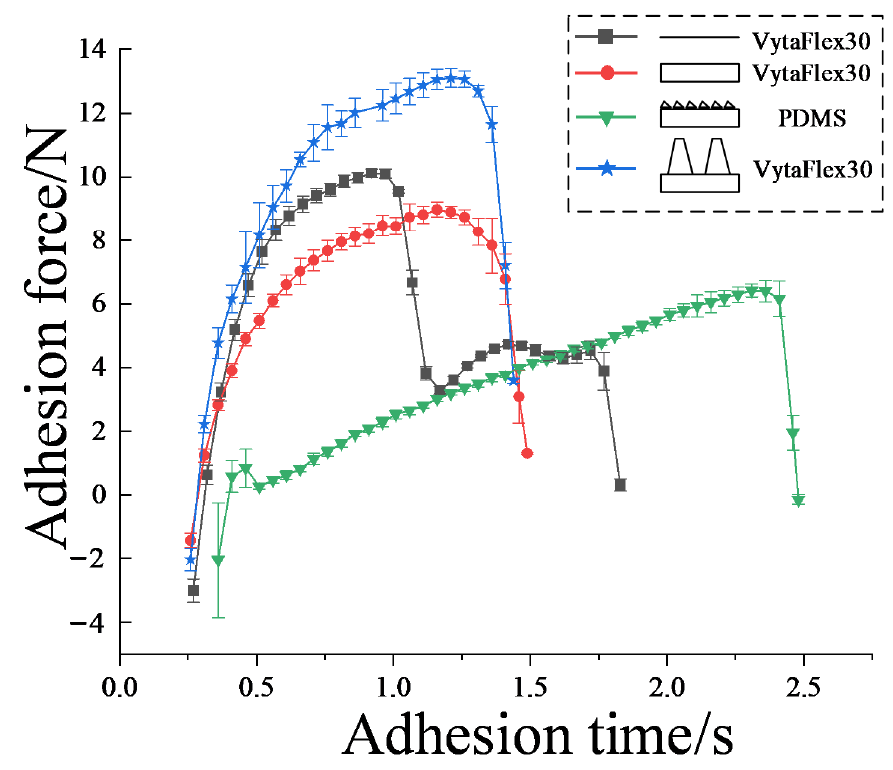
Figure 6. Mechanical testing of discs with different microstructures.